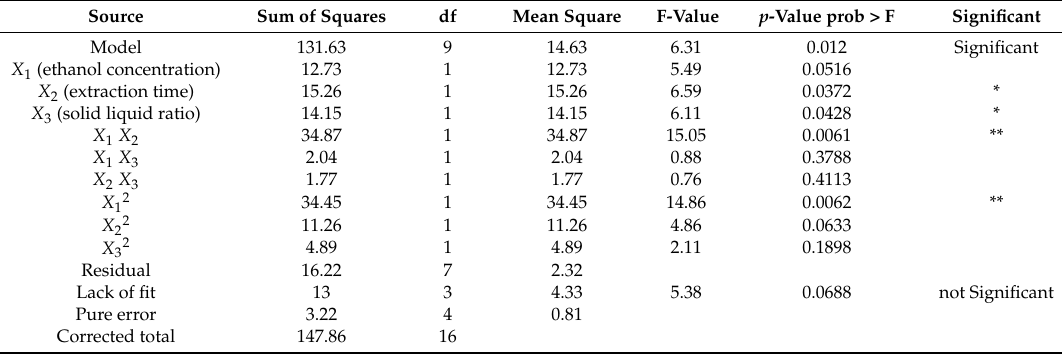
Table 2. Analysis of variance (ANOVA) for response surface quadratic